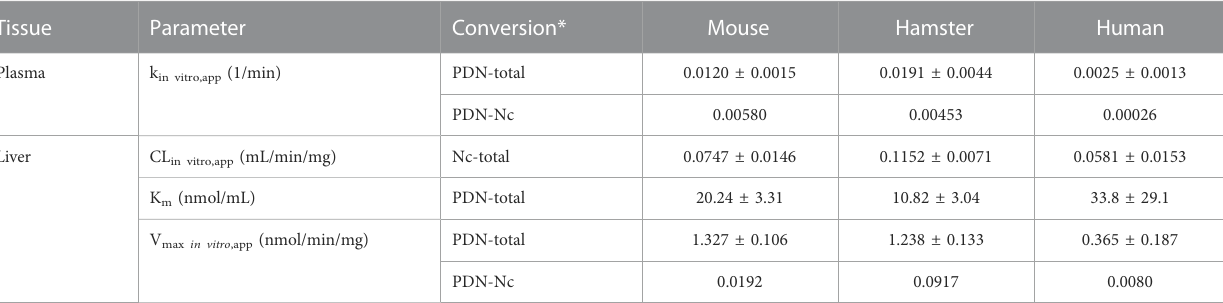
TABLE 3 Apparent in vitro clearance (CL in vitro,app ) of depletion and biotransformation in plasma and liver microsomes (mean ± SD, n = 3).